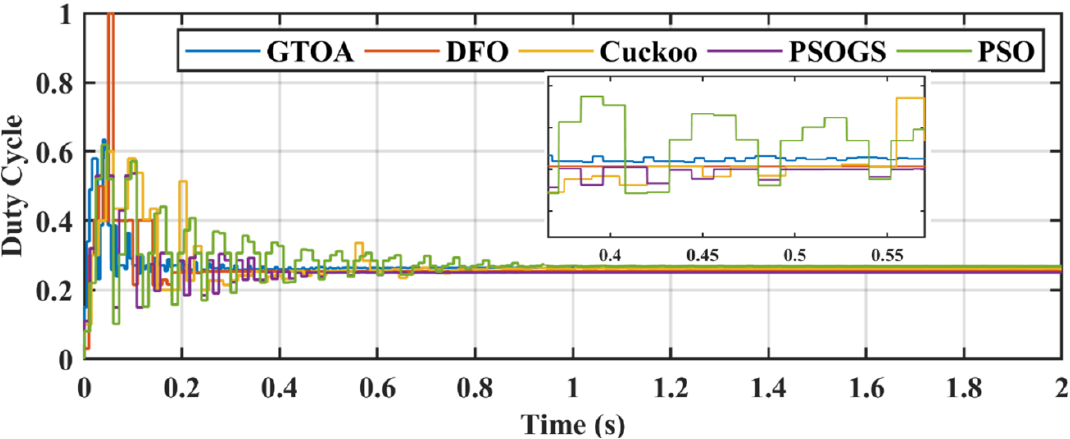
Figure 17. Comparison of duty cycle of GTOA.